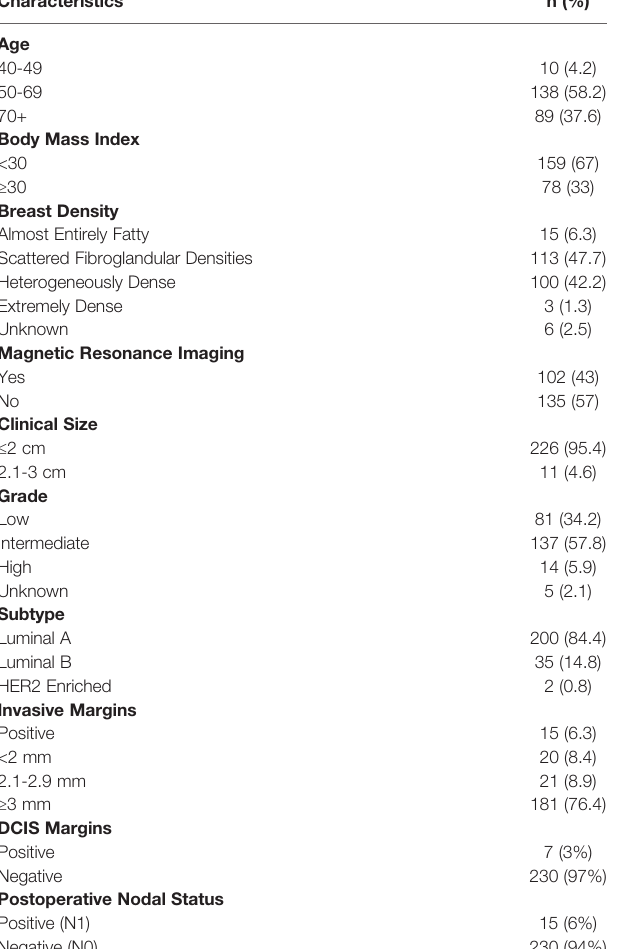
TABLE 1 | Patient characteristics (n =